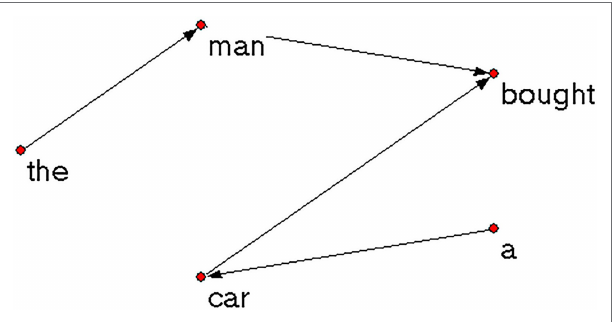
FIGURE 3 | An example of syntactic dependency